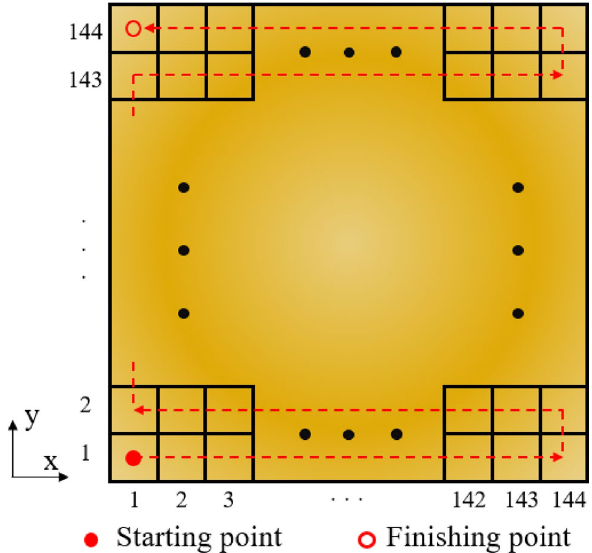
Figure 1. Schematic of the scan